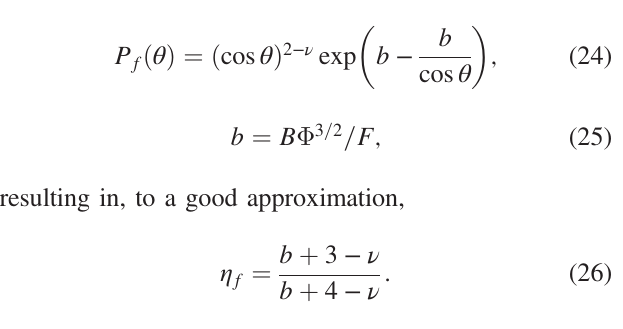
FIG. 4. Integrated current ratio Δ ð θ Þ [Eqs. (21), (27), (33)] evaluated for parameters of Table III. Dashed gray vertical lines correspond to θ for each process, labeled “ T, ” “ ω , ” and “ F, ” for o circle (red line), square (green line), and diamond (blue line), respectively.